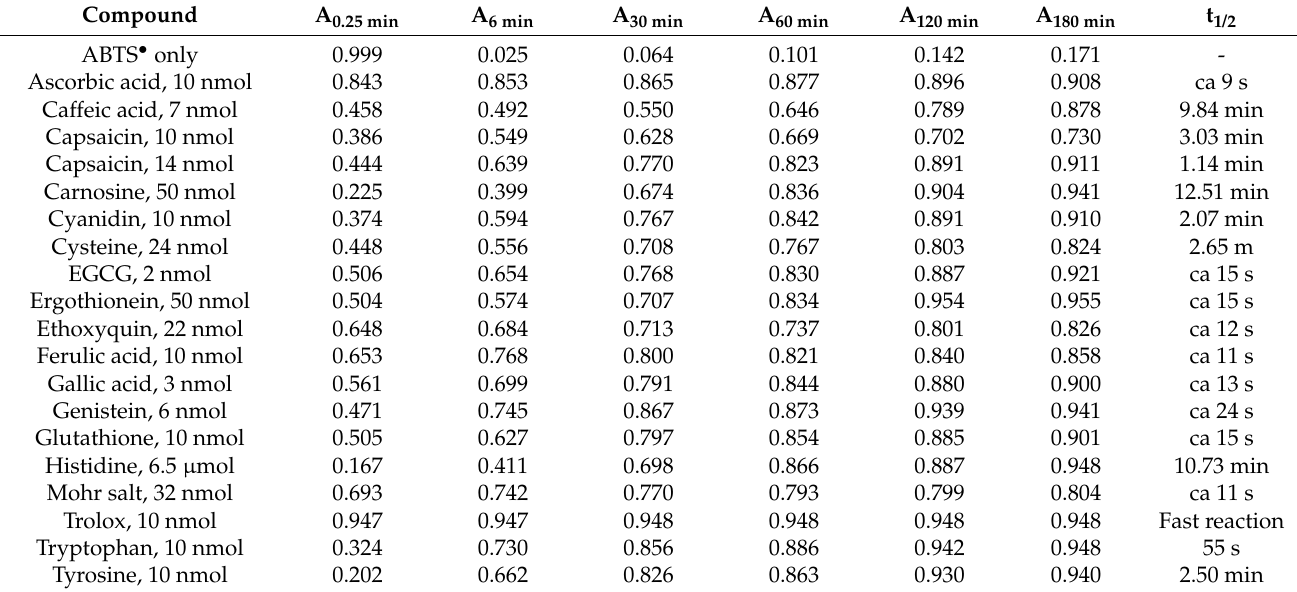
Table 1. Time course of ABTS • reduction by various antioxidants. Initial value of absorbance: 1.0 in all